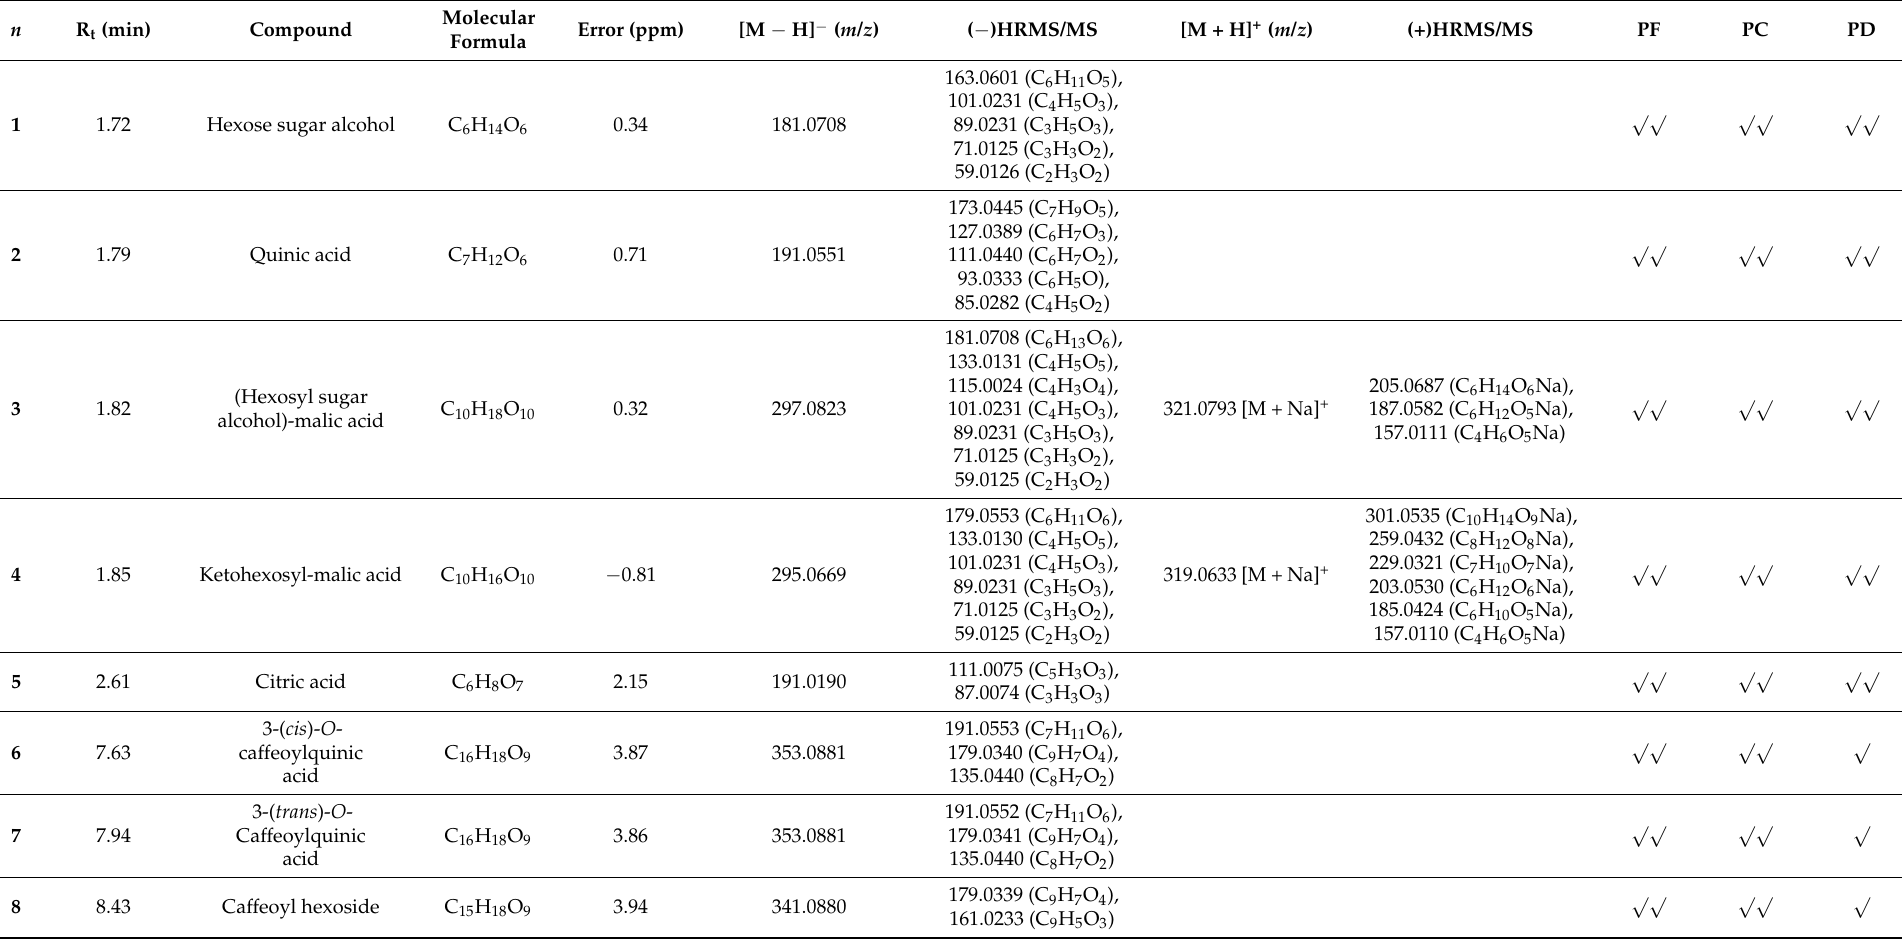
Table 4. Metabolites identified in PF, PC, and PD